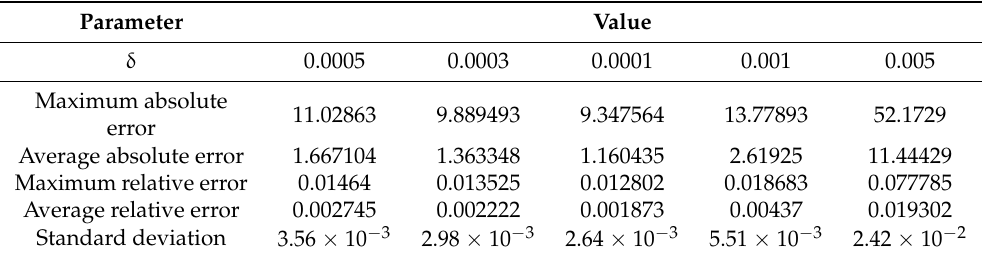
Table 5. Model IV with Gaussian errors in